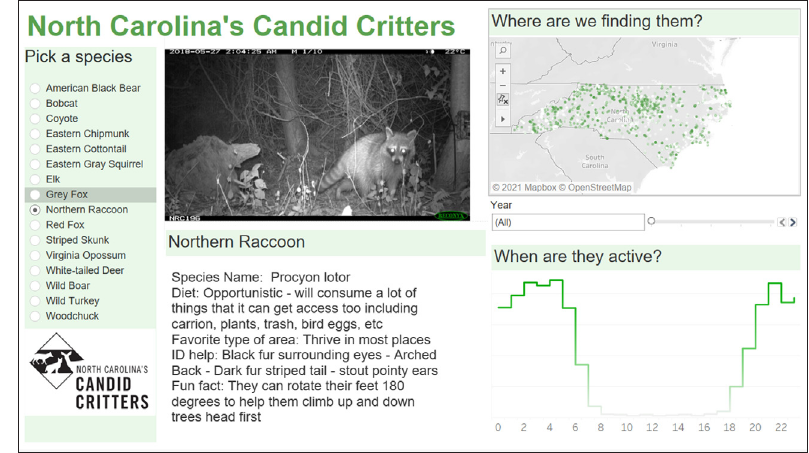
Figure 3 Volunteers can view species’ profiles from North Carolina’s Candid Critters data, which includes the distribution of the species across the state, the animal’s daily activity pattern, and photos obtained in the